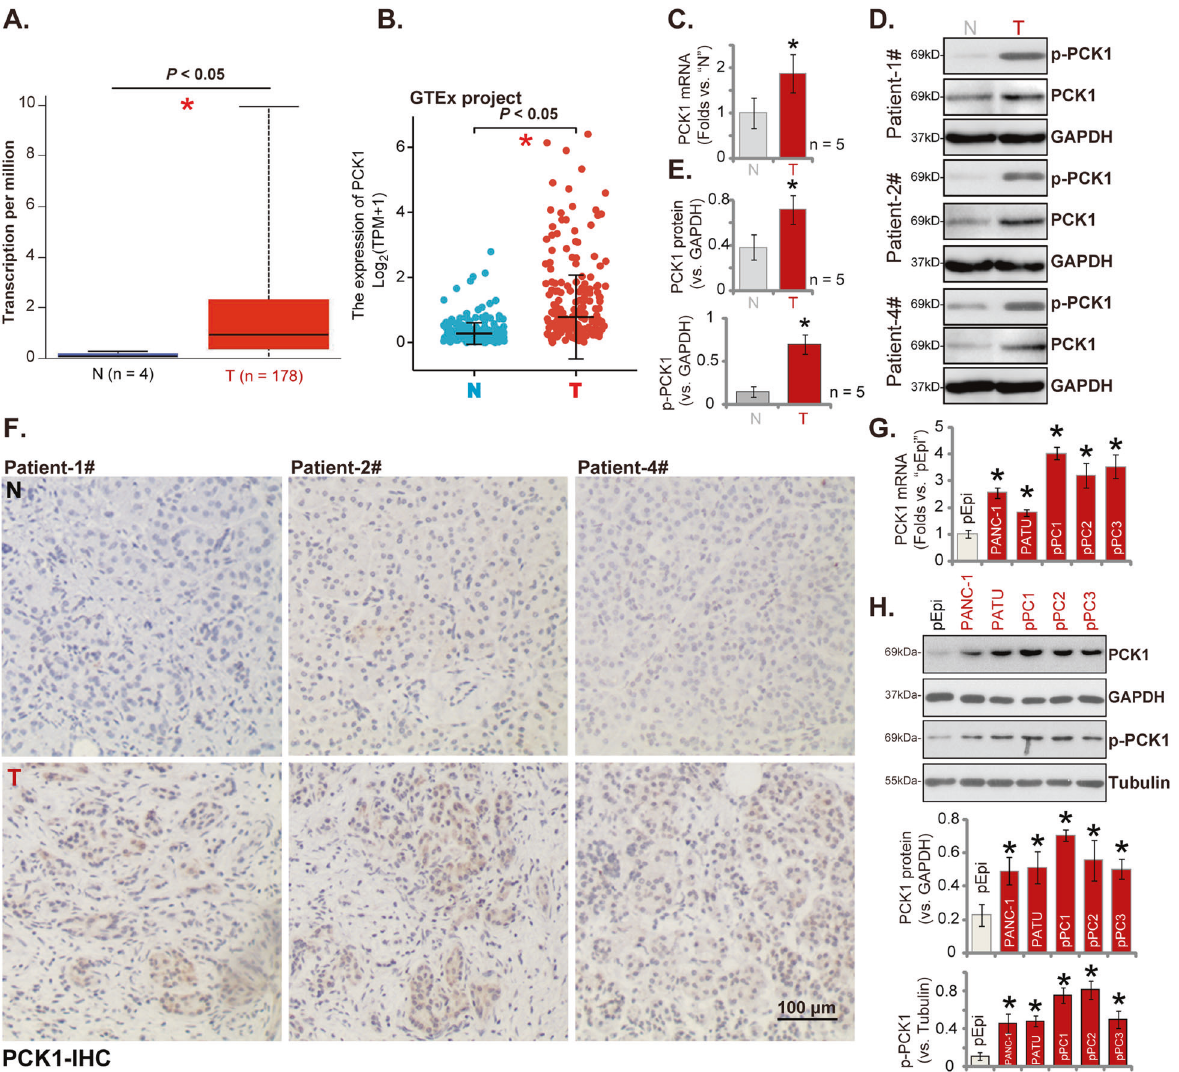
Fig. 1 PCK1 is overexpressed in human pancreatic cancer tissues and cells. TCGA-PAAD cohorts show relative PCK1 mRNA expression in 171 cases of pancreatic ductal adenocarcinoma (PDAC) tissues ( “ T ” ) and four cases of normal pancreatic tissues ( “ N ” ) ( A ). GTEx project shows the RNA-Seq data of PCK1 mRNA expression in primary pancreatic cancer tissues ( “ T ” ) and solid normal pancreatic tissues ( “ N ” ) ( B ). PCK1 mRNA and listed proteins (total and phosphorylated PCK1) expression in fi ve sets ( n = 5) of pancreatic cancer tissues ( “ T ” ) and in normal tissues adjacent to tumor ( “ N ” ) from primary patients were tested by qRT-PCR ( C ). and Western blotting ( D , E ) assays, with results quanti fi ed. PCK1 immunohistochemistry (IHC) staining results of pancreatic cancer tissues and surrounding normal tissues from three representative patients ( F ). Expression of PCK1 mRNA and listed proteins in listed pancreatic cancer cells and primary pancreatic epithelial cells ( “ pEpi ” ) was shown, with results quanti fi ed ( G , H ). PATU stands for “ PATU-8988 ” . Data were presented as mean ± standard deviation (SD). * P < 0.05 vs. “ N ” tissues/ “ pEpi ” cells. Scale bar = 100 μ m ( F